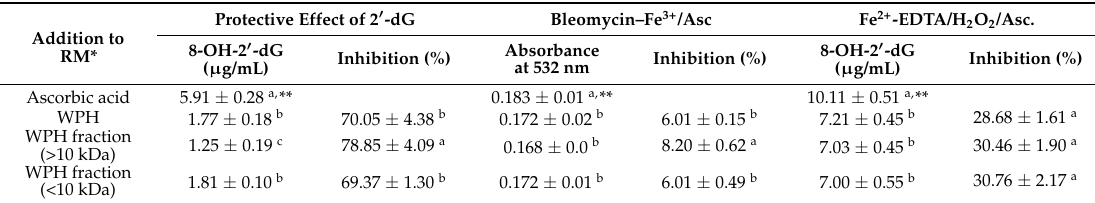
Table 2. Effect of WPH and WPH fractions on the DNA damage induced by bleomycin-Fe 3+ /Asc and oxidation of 2 ′ -dG to 8-OH-2 ′ -dG induced by Fe 2+ -EDTA/H 2 O 2 /Asc.